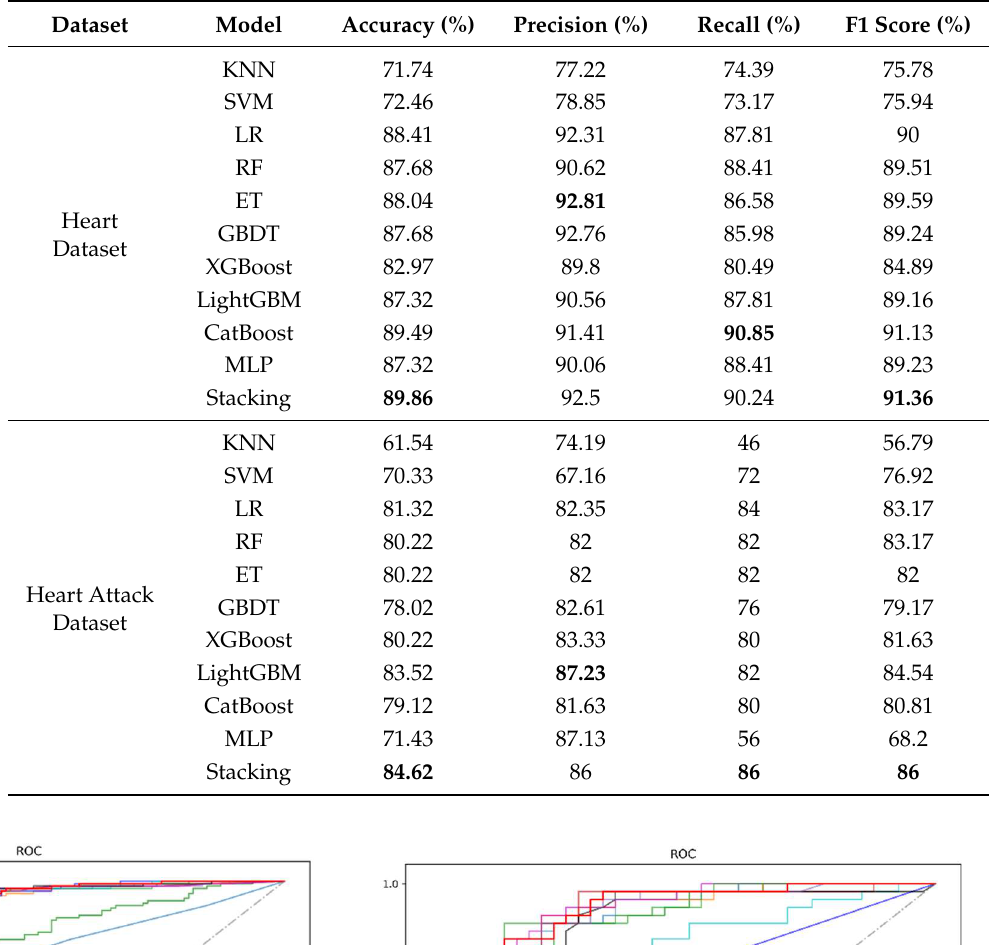
Table 3. Classification results of eleven classifiers.